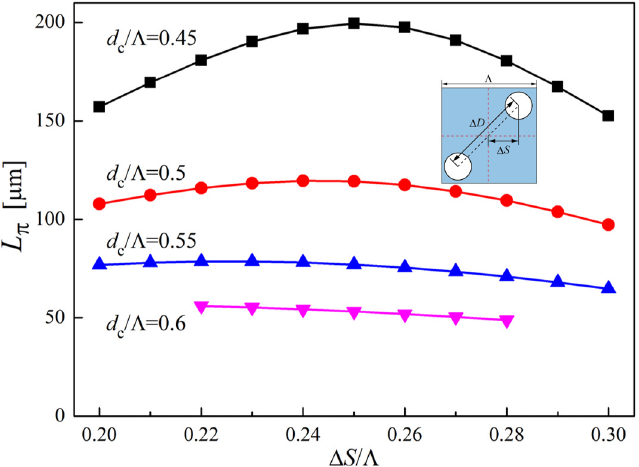
Figure 2. Conversion length as a function of ∆ S with different cladding hole diameters at λ = 1.55 µ m.